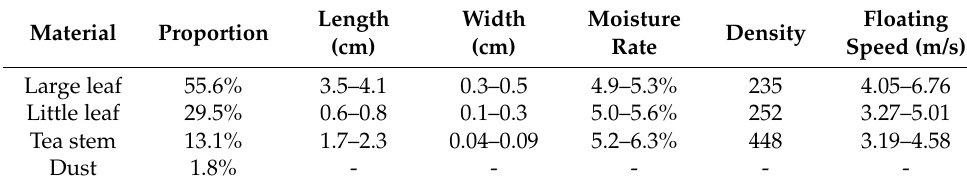
Table 4. Physical parameters of Materials of Lan tea.